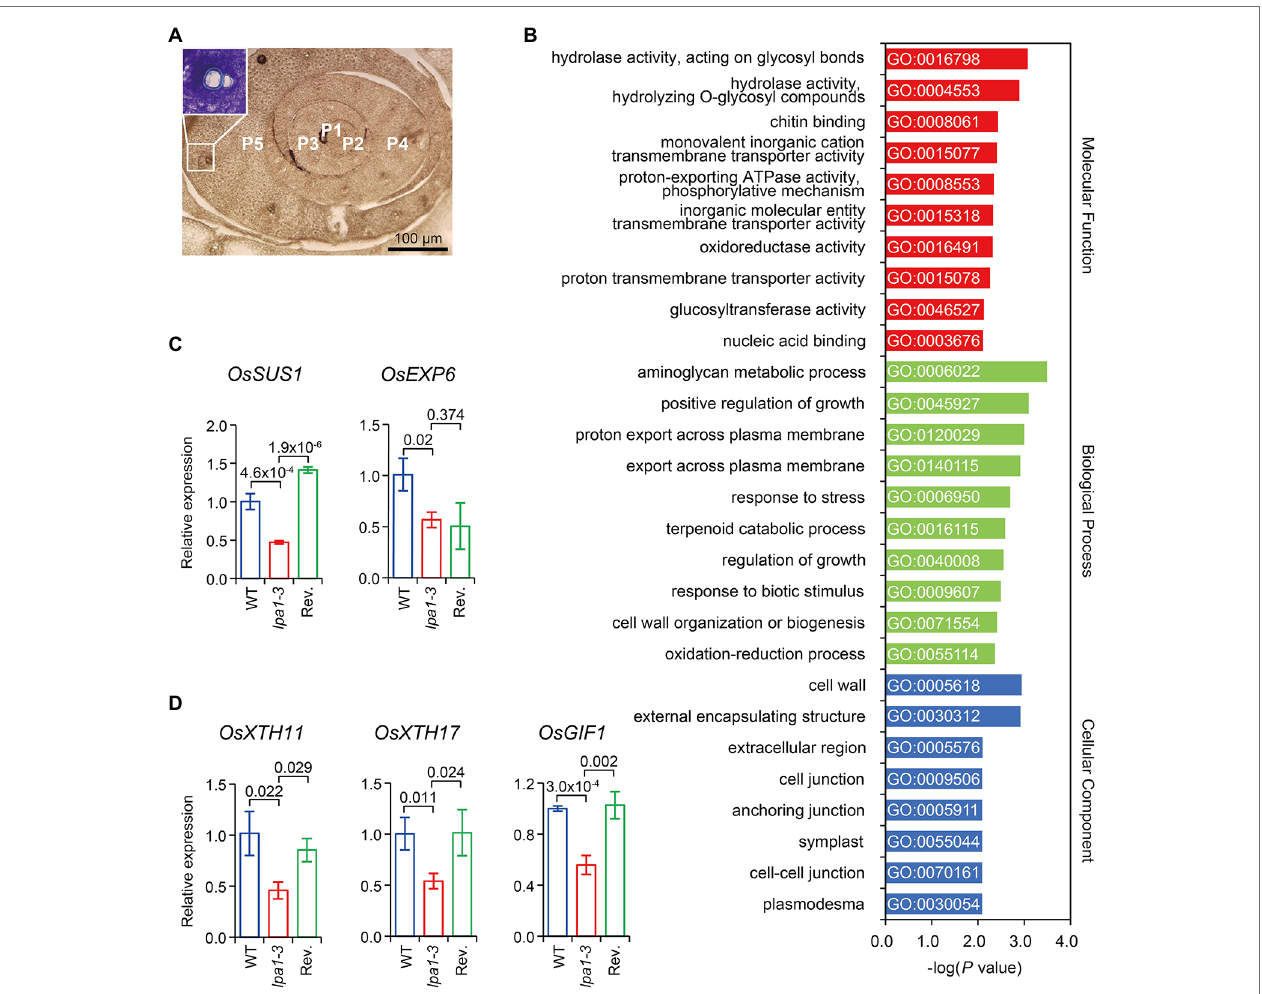
FIGURE 4 | Many LPA1 -dependent differentially expressed genes (DEGs) are related to cell wall organization. (A) Cross sections of immature vascular bundles from leaf primordia. The insert indicates the immature vascular bundles including protoxylems of transition stage (before enlargement of the metaxylem) in P5 that were micro-dissected for RNA-seq analysis. P1–P5 indicate the leaf primordium number. (B) Top 10 enriched gene ontology (GO) terms for each category in DEGs identified from WT and lpa1-3 . (C,D) Expressions of genes related to cell wall synthesis, enlargement (C) , and cell wall loosening (D) in immature vascular. WT, blue line boxes; lpa1- 3, red line boxes; revertant (Rev.), green line boxes. The expressions were determined by qRT-PCR relative to WT, normalized to UBIQUITIN . Bar graphs display mean ± SD. Values of p denoted on the graph, two-tailed, two-sample t -test. The immature vascular samples were dissected and collected from P5 at least 12 plants. Three biological replicates were used for